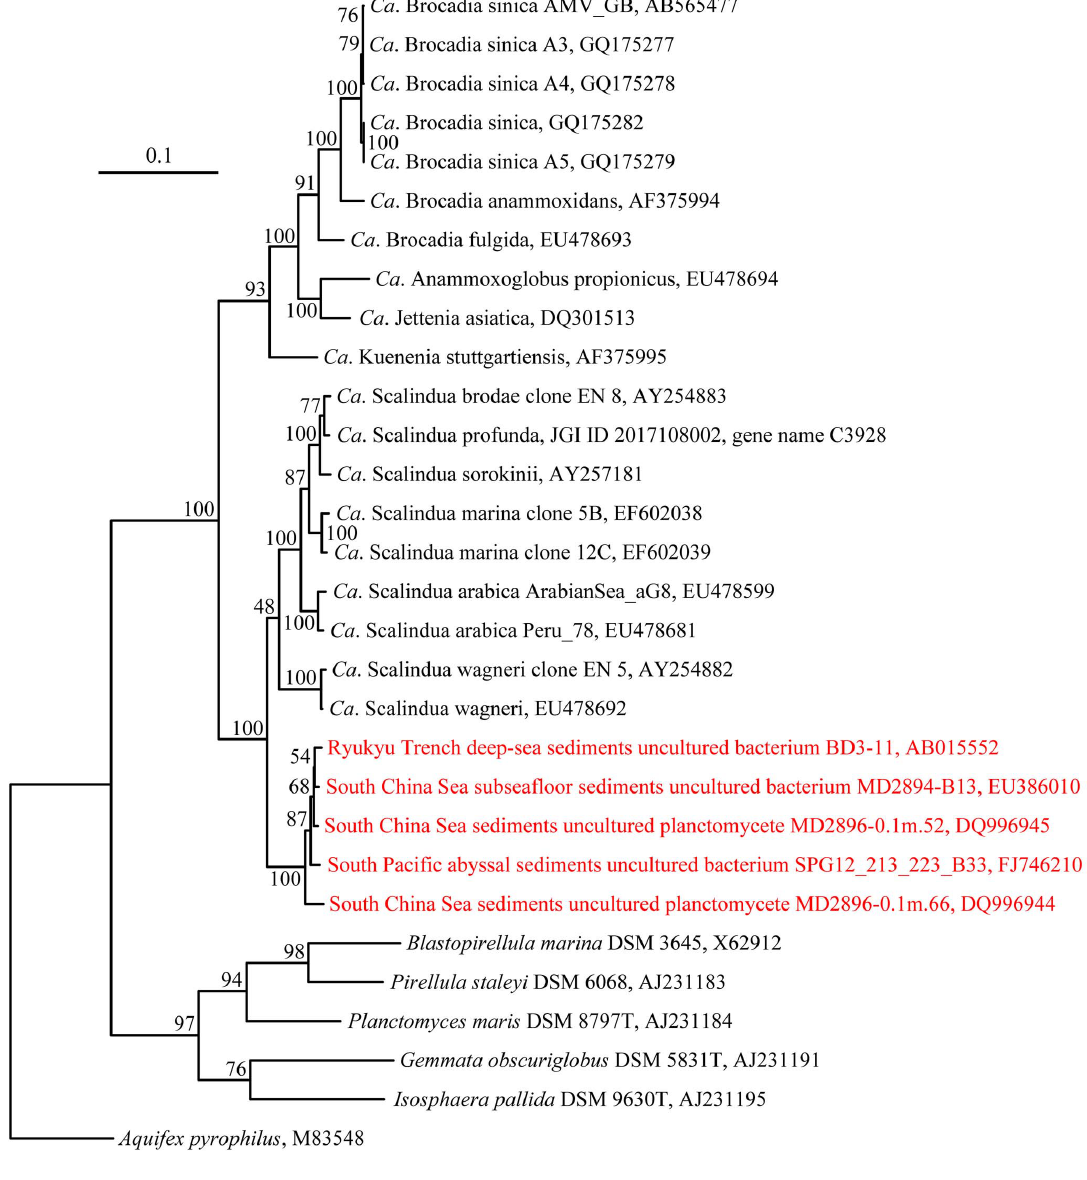
Figure 3. Distance neighbor-joining phylogenetic tree of nearly full-length anammox bacterial and environmental 16S rRNA gene sequences. The tree branch distances represent nucleotide substitution rate and scale bar represents expected number of changes per homologous position. A . pyrophilus 16S rRNA gene sequence was used as outgroup. Bootstrap values (100 resamplings) are shown near the corresponding nodes. Sequences shown in red form a monophyletic cluster and putatively define the new anammox bacterium candidate species, ‘‘ Ca . Scalindua pacifica’’.